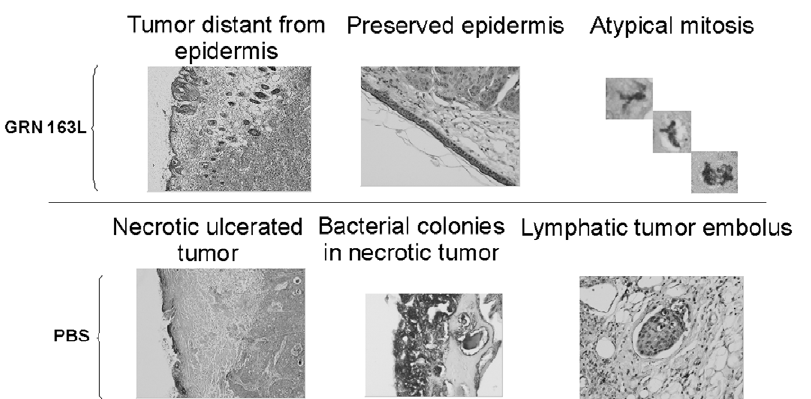
Figure 7. Histological analyses of tumors treated invivo with telomerase inhibitor. Tumors grown in athymic nude mice treated with telomerase inhibitor GRN163L were analyzed histologically after Gimza staining. The upper panel demonstrates less aggressive parameters of tumors treated with telomerase inhibitor, and the lower panel show a more aggressive appearance of tumors treated with PBS only.